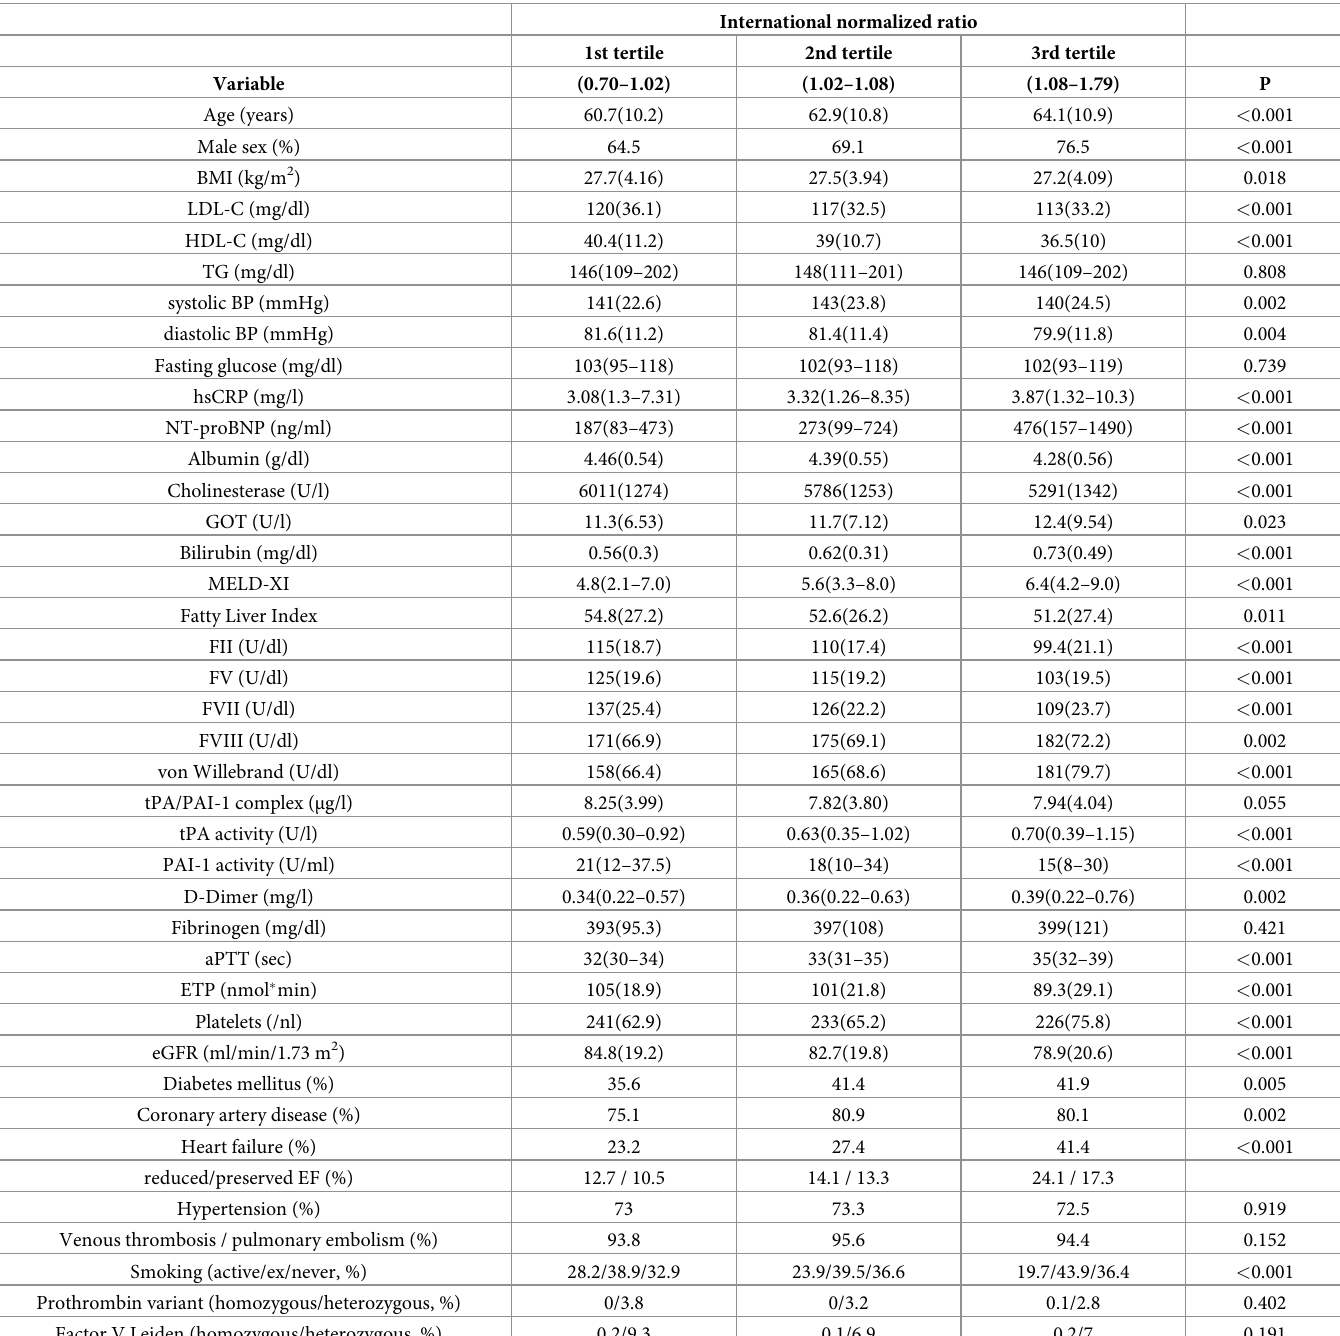
Table 1. Study characteristics according to tertiles of INR (mean (SD) or median (25 th -75 th